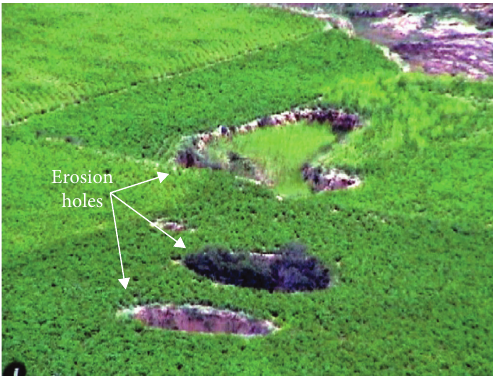
Figure 3: Erosive holes on the top of the loess